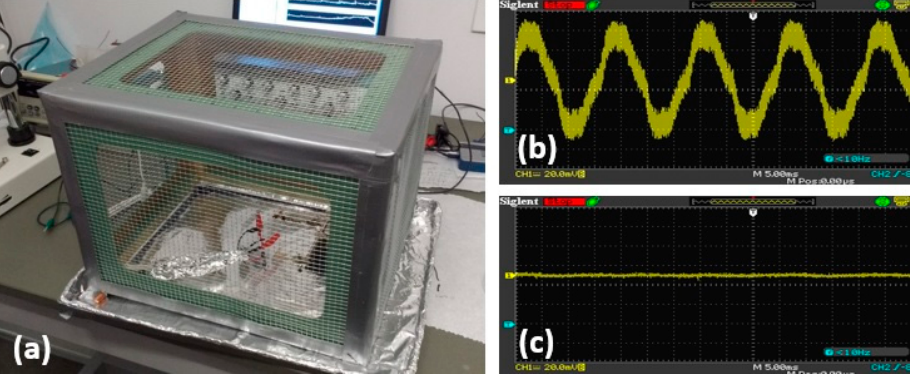
Figure 3. ( a ) The in-house Faraday cage; ( b , c ) Ambient EMI without and with Faraday